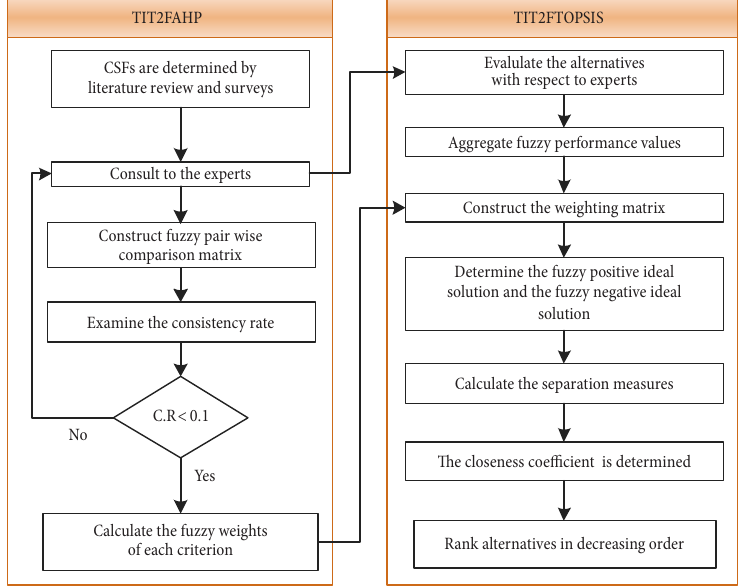
Fig. 2. The proposed hybrid TIT2FAHP and TIT2FTOPSIS methodology